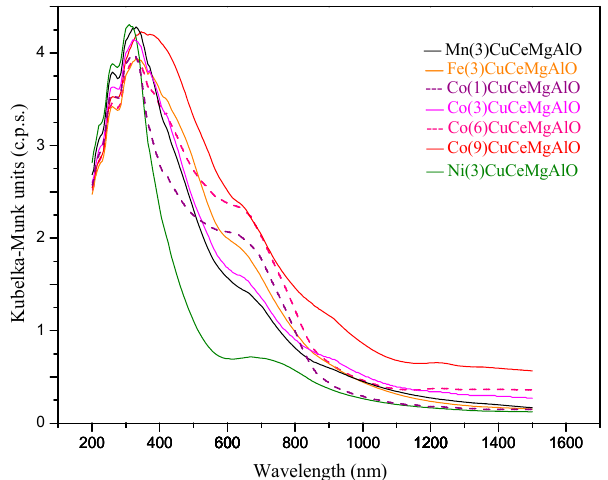
Figure 7. The X-ray photoelectron profiles of Co 2p for the Co(x)CuCeMgAlO mixed oxides: (A) x =